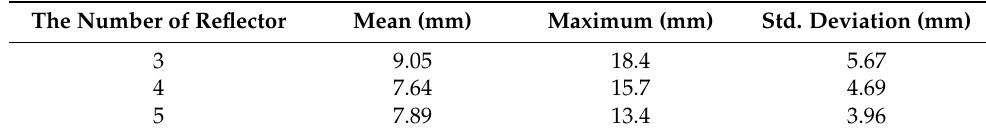
Figure 8. Initial point localization error in initialization mode. Table 1. X position